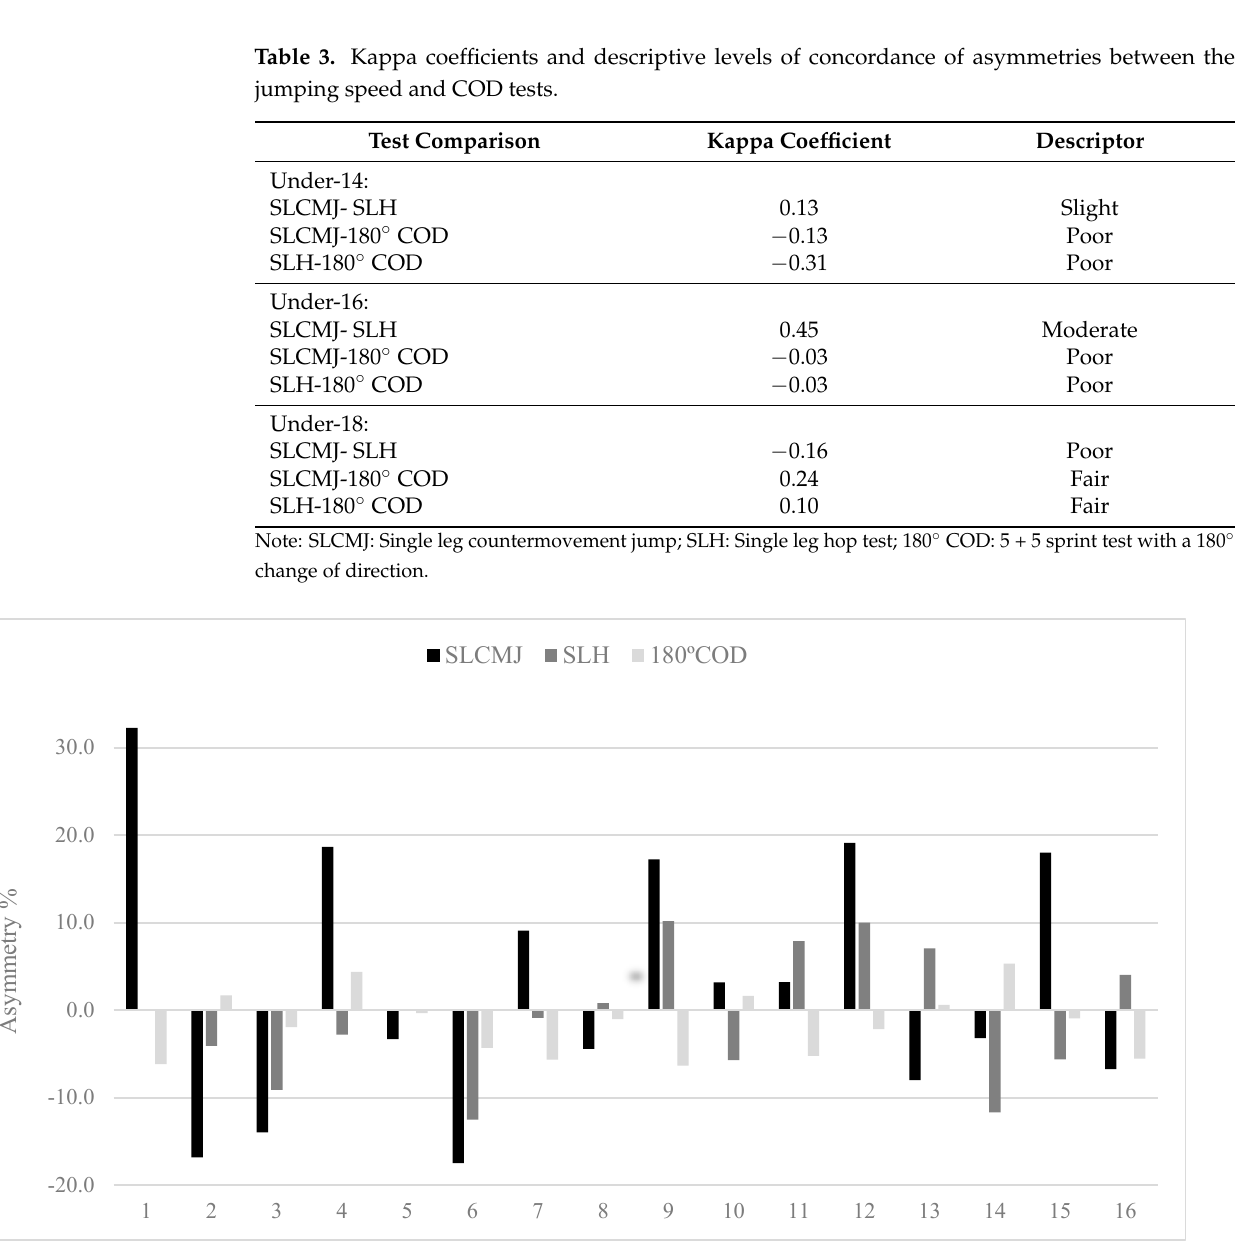
Table 3. Kappa coefficients and descriptive levels of concordance of asymmetries between the jumping speed and COD tests.